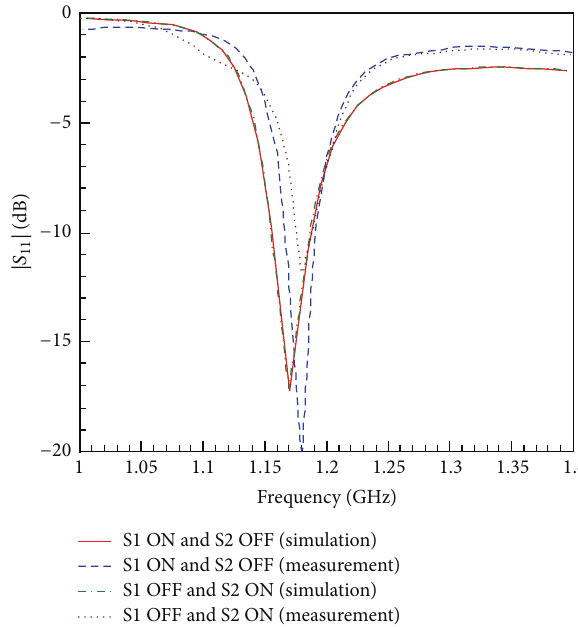
Figure 15: Measured and simulated impedance mismatch of the fabricated prototype of the two-CLL NFRP element reconfigurable antenna. State 1 (red) and State 2 (blue).